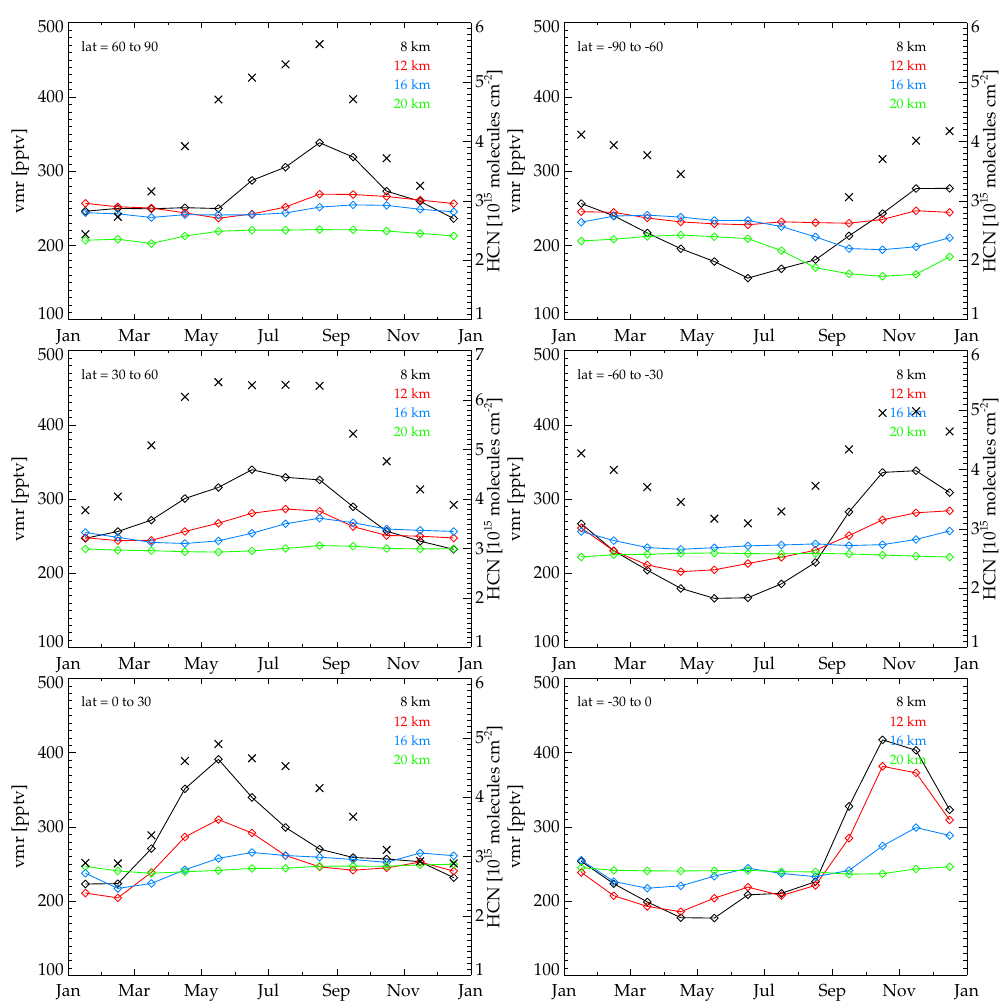
Figure 6. Climatological monthly mean HCN volume mixing ratios measured by MIPAS (solid lines) at the altitudes of 8 (black), 12 (red), 16 (blue) and 20km (green) in the latitude bands 60–90 ◦ (top row), 30–60 ◦ (middle row) and 0–30 ◦ (bottom row) for the Northern (left column) and Southern Hemisphere (right column). Black crosses (x) are climatological monthly mean HCN column amounts from ground- based FTIR measurements at the NDACC stations Kiruna (top left), Toronto (middle left), Izaña (bottom left), Arrival Heights (top right) and Lauder (middle right). For the latitude band 0–30 ◦ S (bottom right) no ground-based data were available. All data sets are averaged over the time period 2002 to